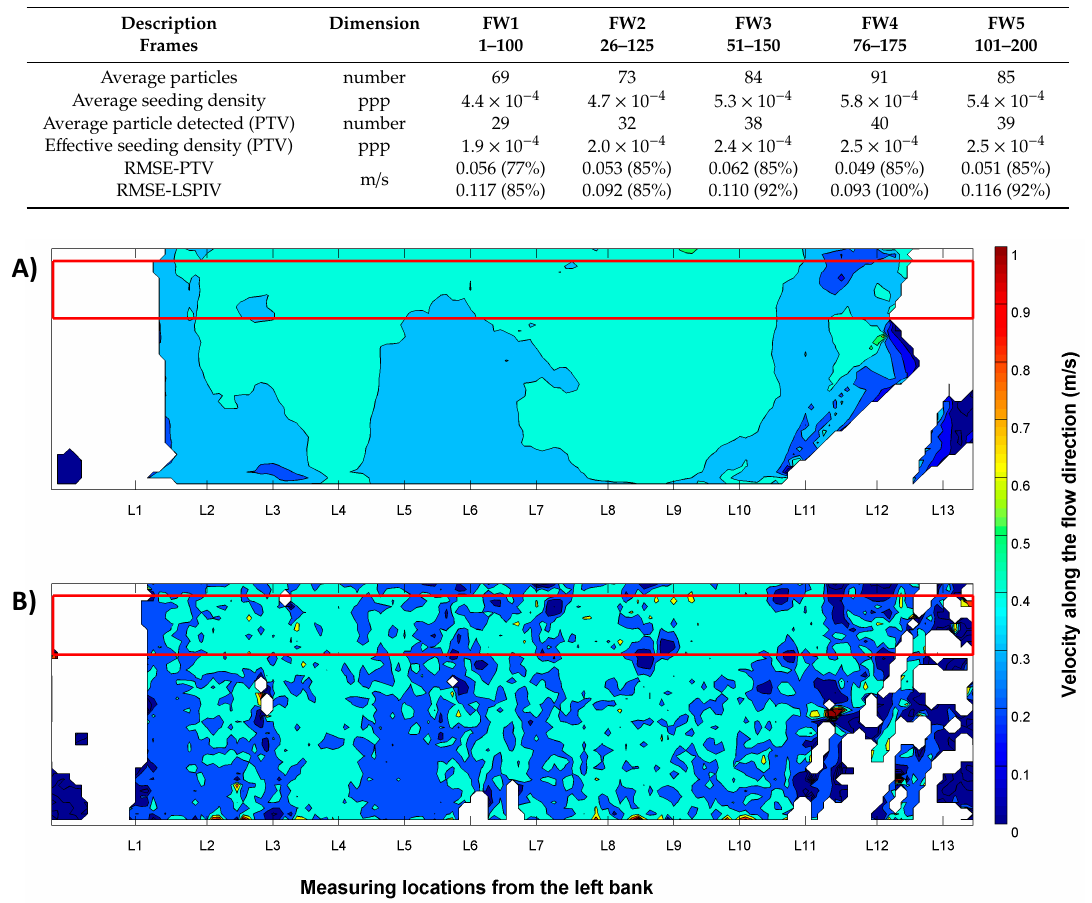
Table 4. Average seeding characteristics of frame sequences with root mean square error (RMSE) computed for different techniques. Percentage of locations with estimated value using image velocimetry techniques shown in parentheses. FW, frame window; PTV, particle tracking velocimetry; LSPIV, large-scale particle image velocimetry.